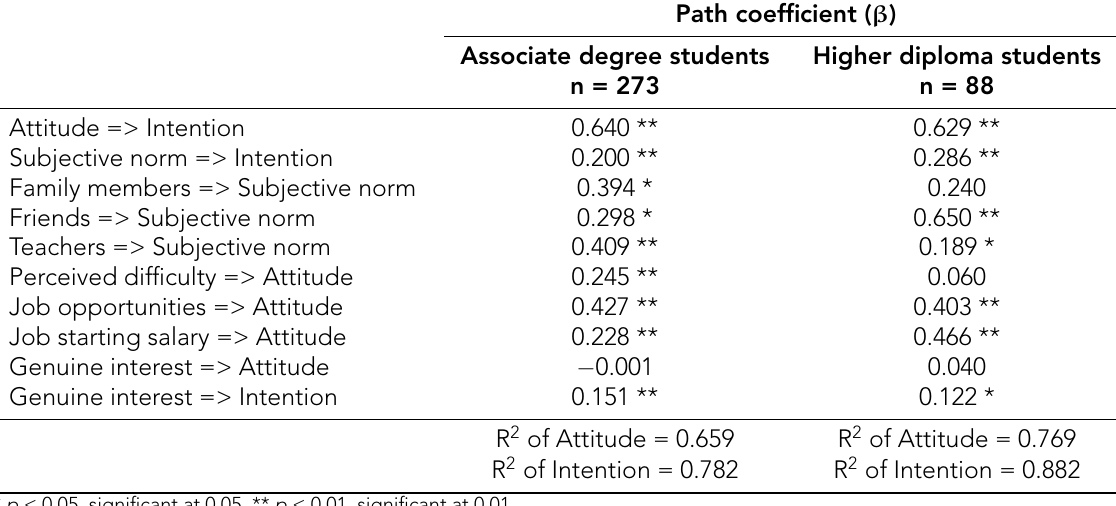
Path coefficient ( β